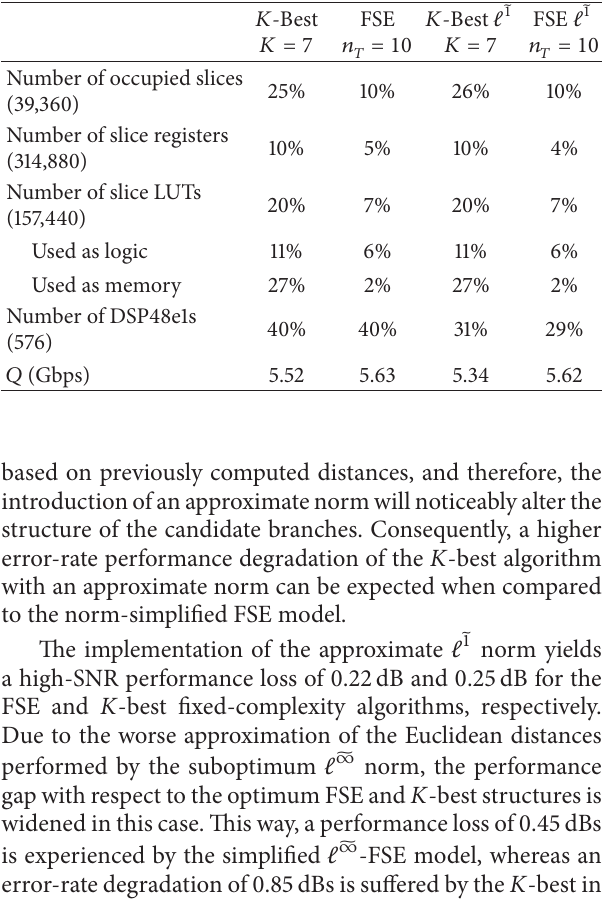
Figure 8: BER performance degradation introduced by approximating the ℓ 2 norm by the simplified ℓ (a) and K -best ( 𝐾 = 7 ) (b) tree-search approaches.